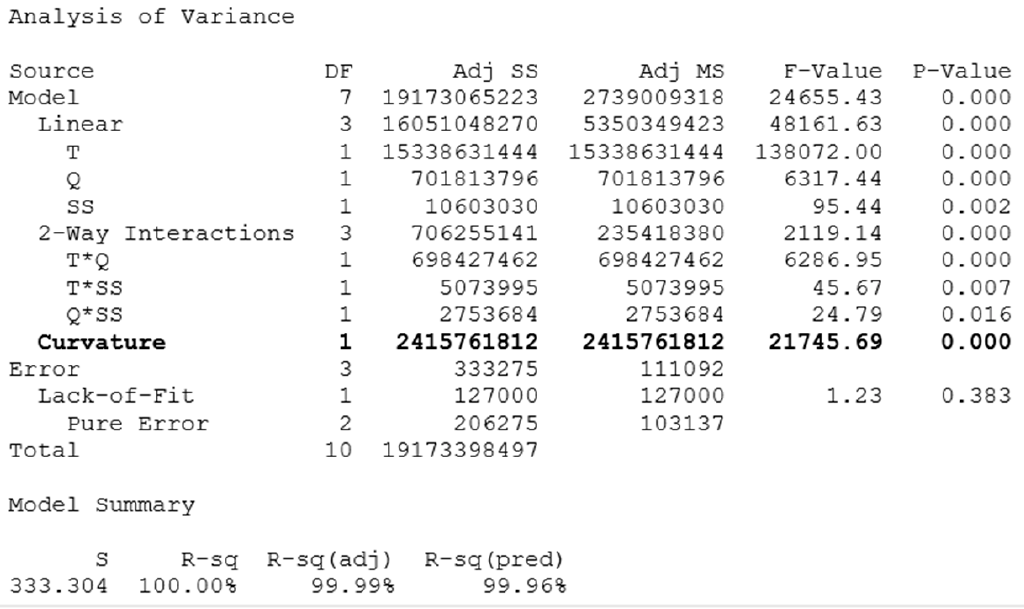
Figure 5. Analysis of variance of factorial regression.